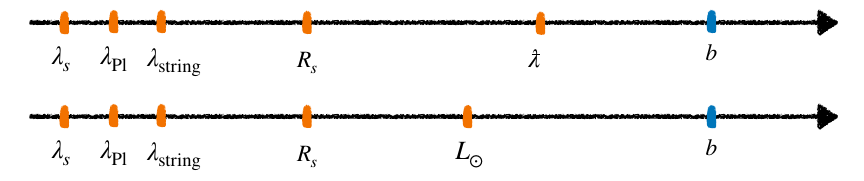
Figure 1 . Scale lengths of the system. Bottom: tidal relative corrections ( L (cid:12) /b ) n are largest and dominate the modifications to the leading eikonal. Top: the most important corrections to leading eikonal arise from higher-derivative operators generated by particles of Compton wavelength ¯ λ = 1 /m e that are running in loops, as long as α ¯ λ 2 (cid:29) R s and b (cid:29) ¯ λ . For b (cid:28) ¯ λ resummation to all orders in ¯ λ/b is needed, corresponding to work with a new EFT where new degress of freedom are propagating. A typical example of δθ/θ , to first order in the coupling constant, is ∼ α log 2 ¯ λ/b in this